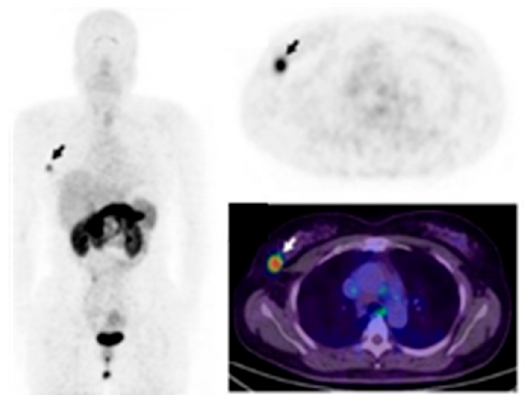
Figure 3. PET/CT imaging of gastrin-releasing peptide receptor and integrin α v β 3 expression using the heterodimeric tracer [ 68 Ga]BBN-RGD, in a patient with ER+, PR+, and HER2+ invasive ductal carcinoma. (Figure adapted with permission from Zhang J. et al. (2018) [55] Creative Commons Attribution (CC BY-NC) license (https://creativecommons.org/licenses/by-nc/4.0/).